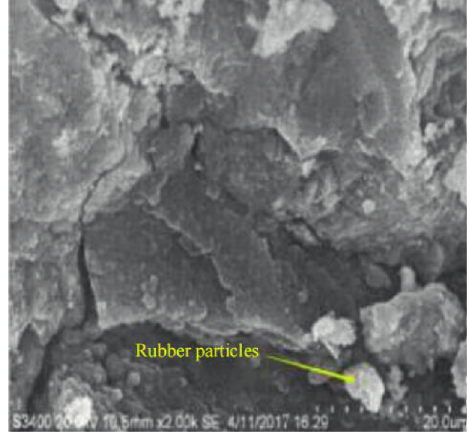
Figure 24: Cement-stabilized recycled aggregate with rubber